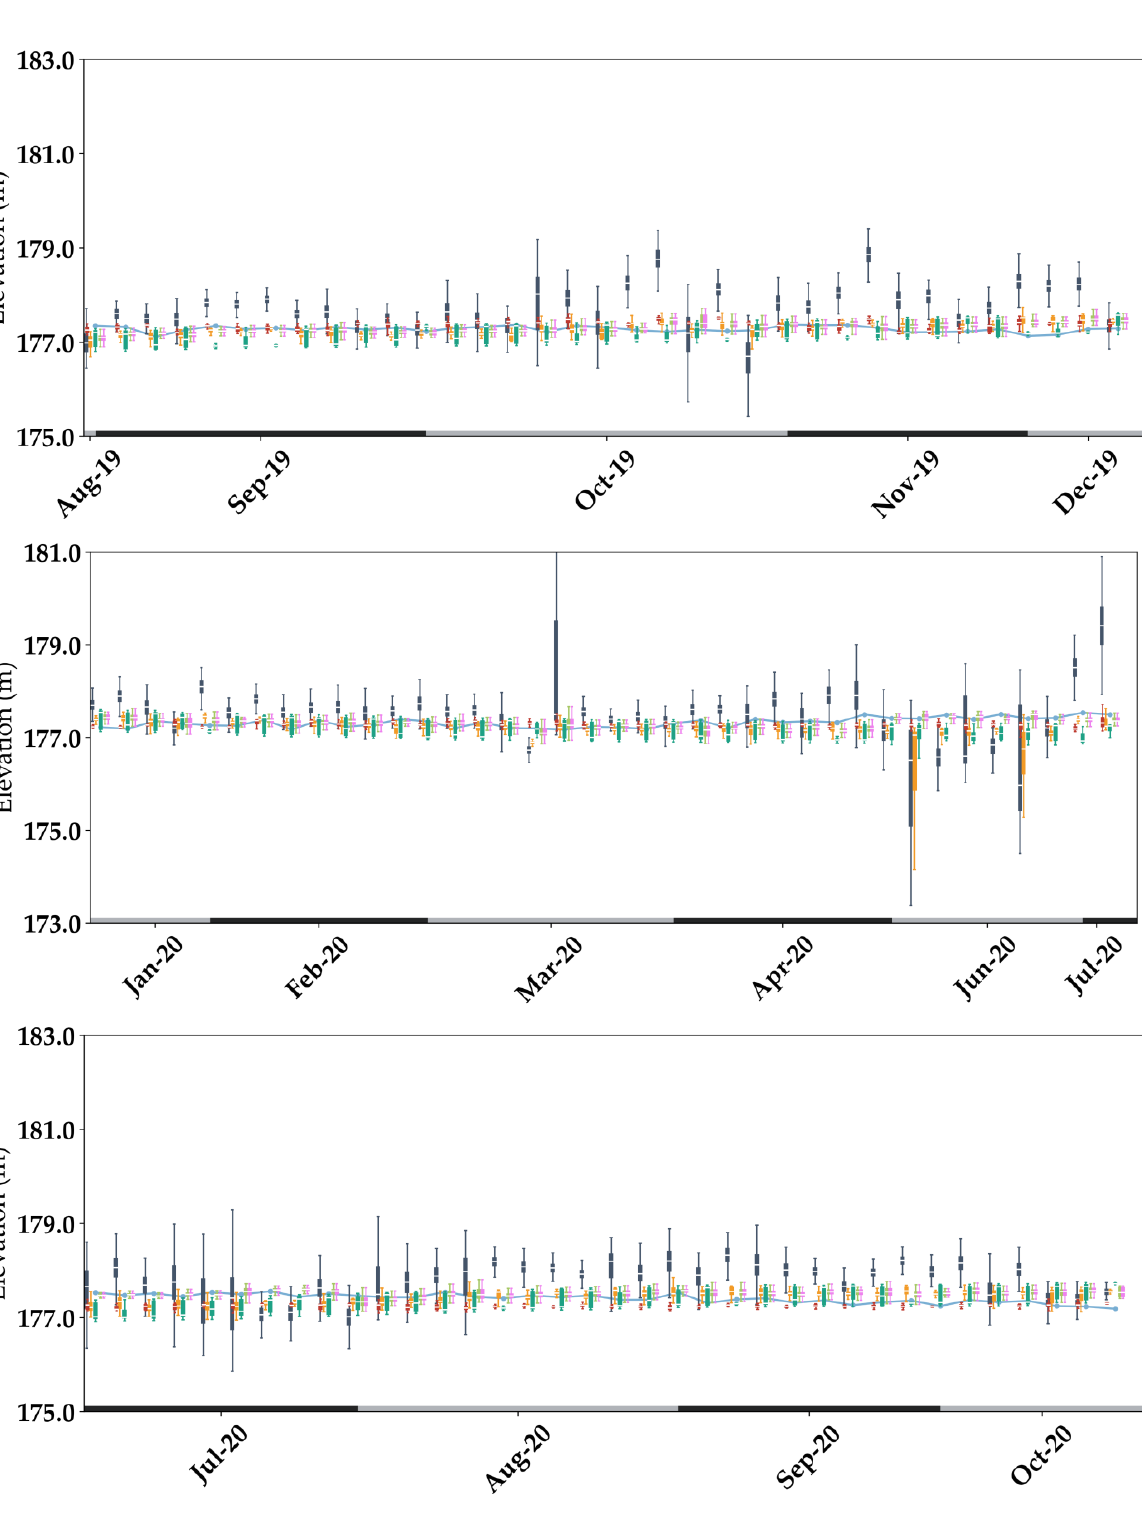
Figure A7. Boxplot by track of the original estimated elevations by GEDI over Lake Huron and the five tested models presented in Section 3.1.3. The green line represents in situ elevations. RF CV represents the 5-fold cross-validation results over Lake Huron. RF Erie → Huron , RF Ontario → Huron , RF Michigan → Huron , and RF Superior → Huron represent the results of the models trained over Lakes Erie, Ontario, Michigan, and Superior, respectively, applied over Lake